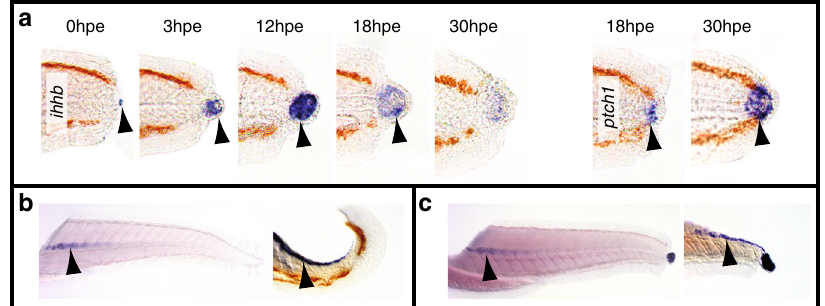
Fig. 4 The Hedgehog pathway is activated immediately after tail excision. a ihhb expression is detected within the notochord bead and continues until 30 hpe (0 hpe 2/10, more than 8/10 for the other time points, number of experiments = 3). Expression of ptch1 is upregulated by 18 hpe and continues after 30 hpe (10/10 for both time points, n = 2). Arrowheads point to expression domains. b Oblique and coronal sections reveal that ihhb is expressed in the notochord before (12/14, number of experiments = 2). c ihhb is expressed in the notochord after tail excision (7/7, number of experiments =